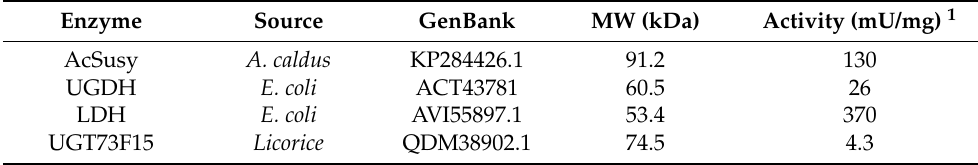
Table 2. Properties of enzymes utilized in this study.